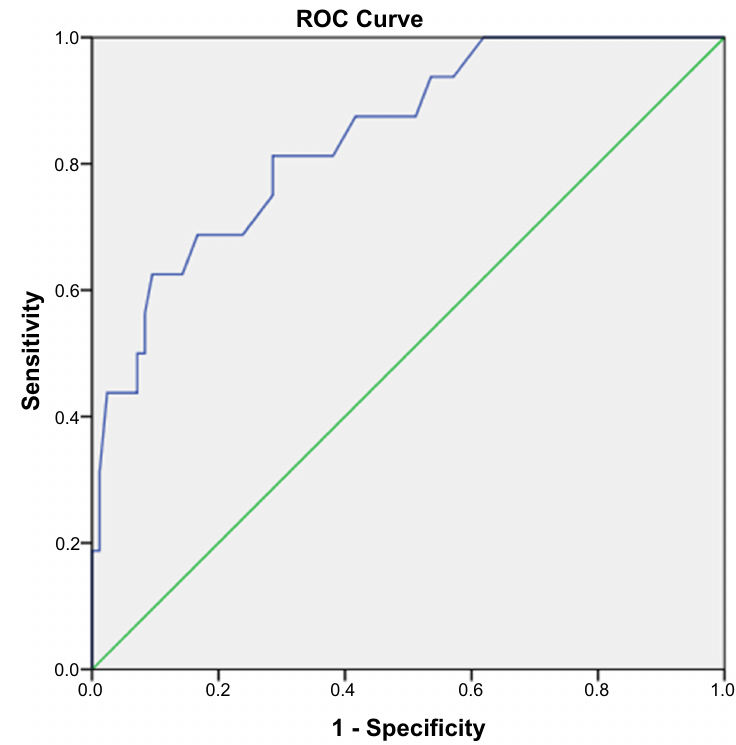
Figure 2. ROC curve of the